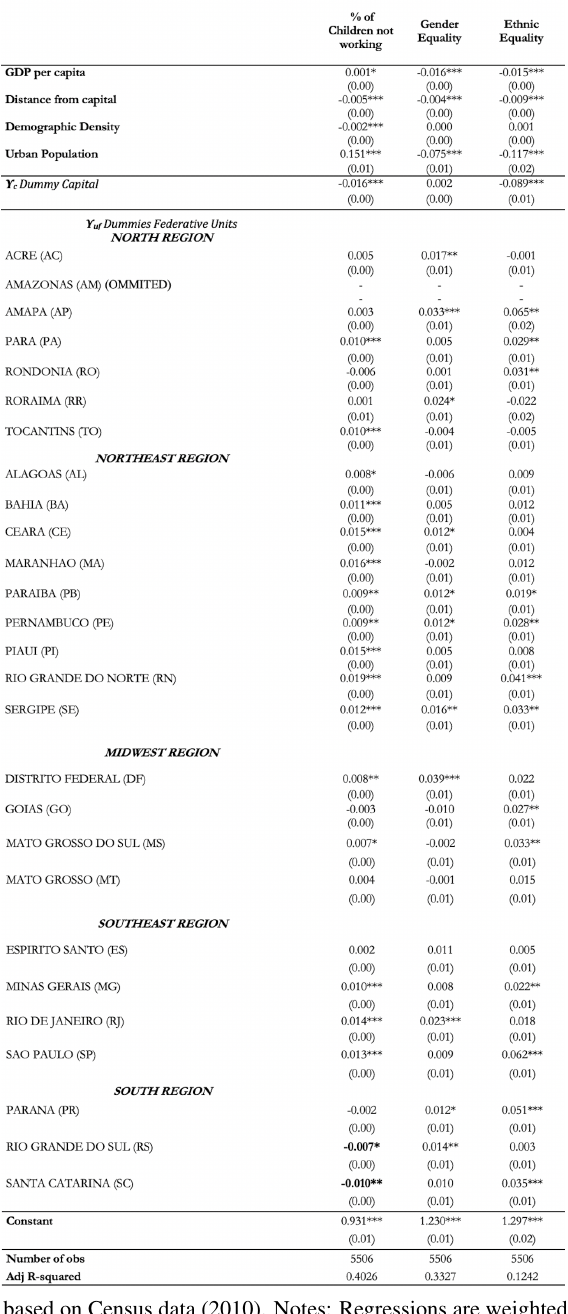
Table 7: Labor Standards Regressions MODEL